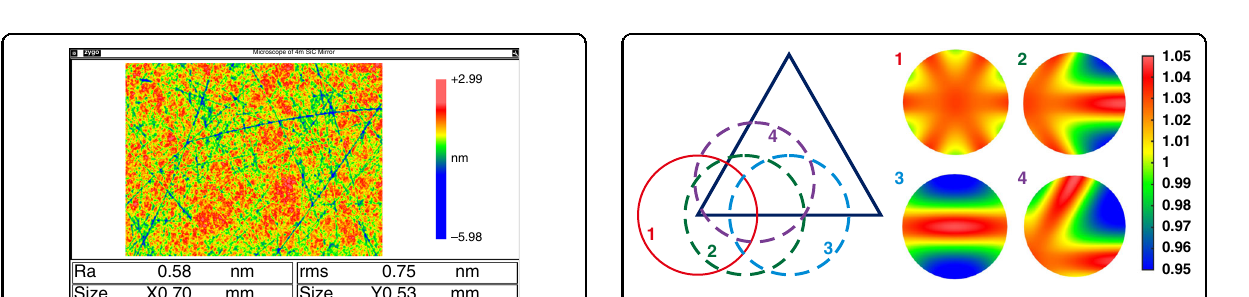
Fig. 13 FEM simulation of pressure distribution of polishing tools at different positions. The differences of tool ’ s pressure distribution at 1 – 4 points during a triangular lightweight structure polishing.